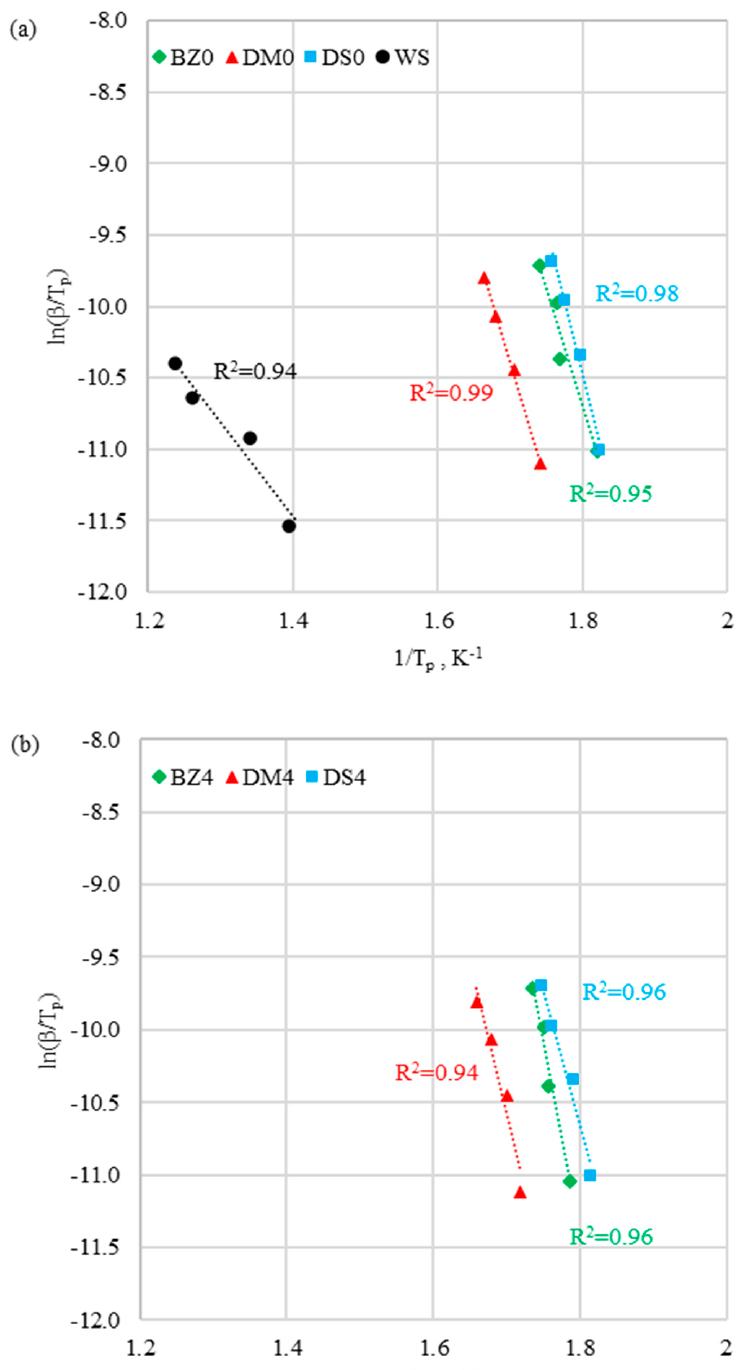
Figure 7. Activation energy calculation by Kissinger method for ( a ) fuels without halloysite and ( b ) fuels with halloysite.